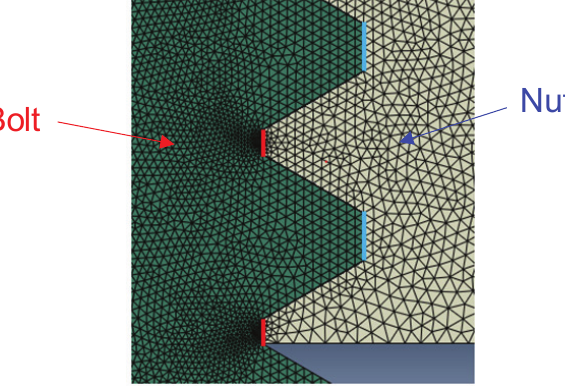
Figure 8. Stress concentration factor (SCF) analysis at the root of the threads in the bolt (red lines) and the nut (blue